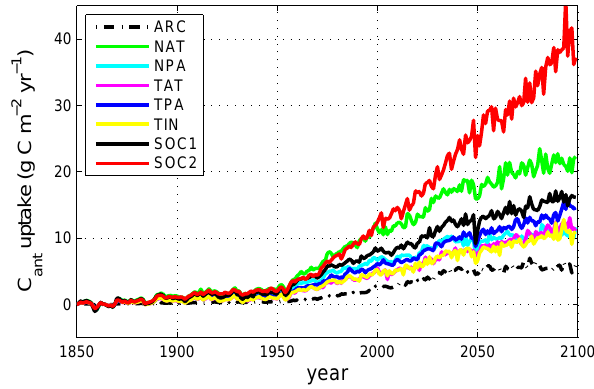
Fig. 5. Time series of area-weighted annual C ant uptake for differ- ent ocean regions. Region definitions are given in Fig. 4. Units are in (gCm − 2 yr − 1